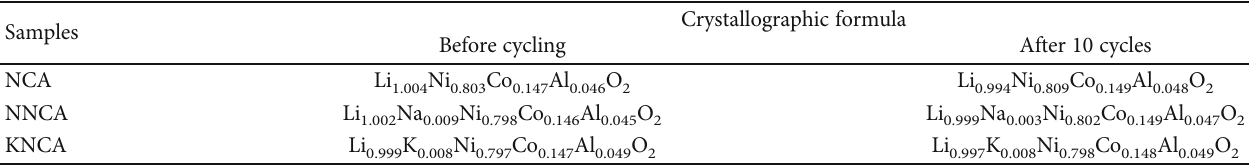
Crystallographic